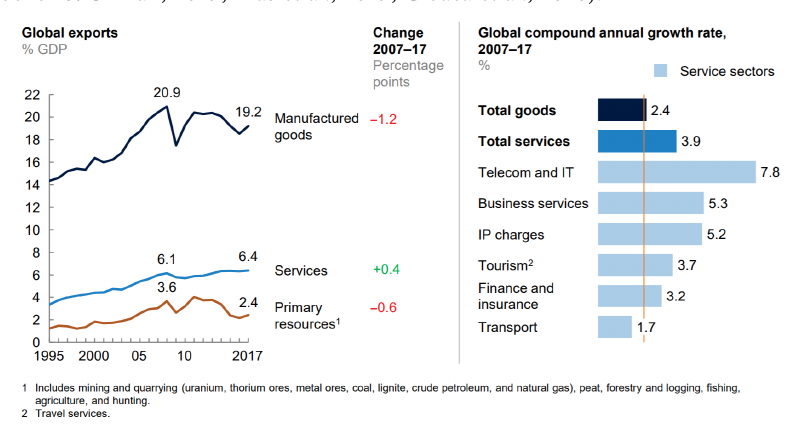
Figure 3. Global dynamics of the service sectors over the period 2007–2017 (source: Lund et al., 2019) The experts were selected based on 5 criteria related to their overall competence: (1) ongoing or not later than one year ago finished projects of NSD; (2) overall work experience in companies of the service sector ( not less than 11 years ); (3) overall experience in NSD ( not less than 6 years ); (4) education ( higher education ); (5) current job position ( managing position ). According to Pridotkienė and Pridotkas (2012), the most accurate results can be obtained when experts have no chances to impact the opinions of each other, as a result, all respondents were selected from different